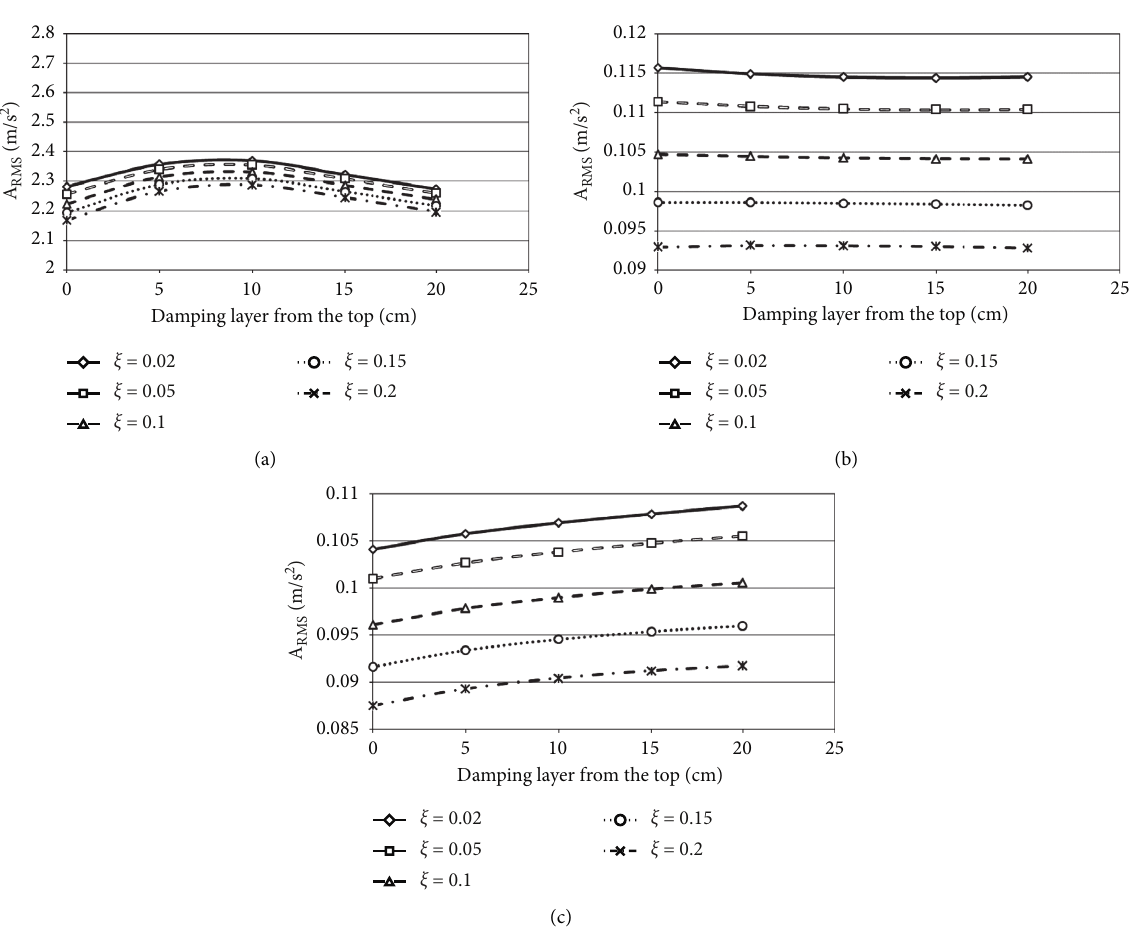
Figure 12: Effects of damping layer position on vibration reduction. (a) Point A. (b) Point C. (c) Point